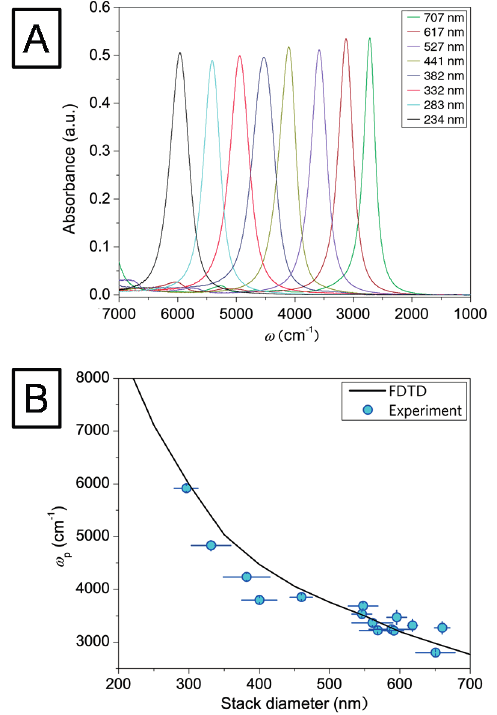
Figure 6. ( A ) IR absorption measurements of nanodisc arrays showing the tunability of the plasmon resonances by variation of the disc diameters; ( B ) Blue circles represent the measured spectral positions of the IR resonances of the nanodisc arrays. The black curve was calculated for a three dimensional model of the nanodisc array using finite difference time domain (FDTD) simulations, in good agreement with the experimental